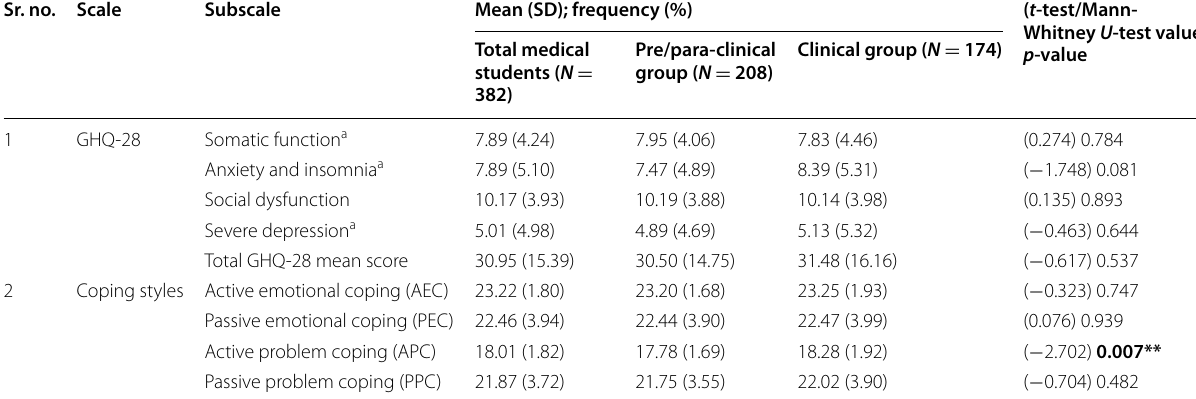
GHQ-28 General Health Questionnaire-28, SD Standard deviation ** p < 0.01 a Mann-Whitney U -test (mean < 2 SD)